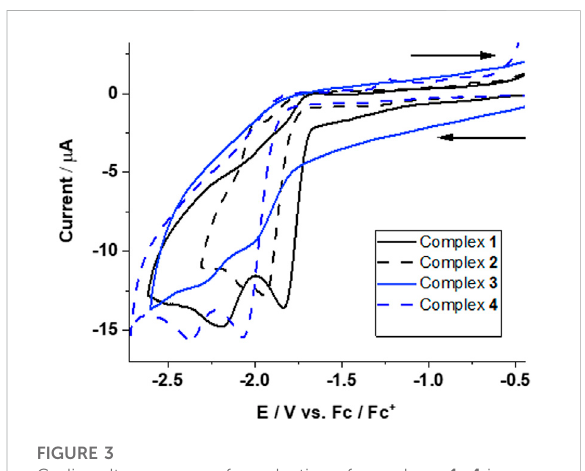
FIGURE 3 Cyclic voltammograms for reduction of complexes 1 – 4 in CH 3 CN at a scan rate of 0.1 V s − 1 . Assignment of redox transitions can be done by quantum chemical calculations (see text for